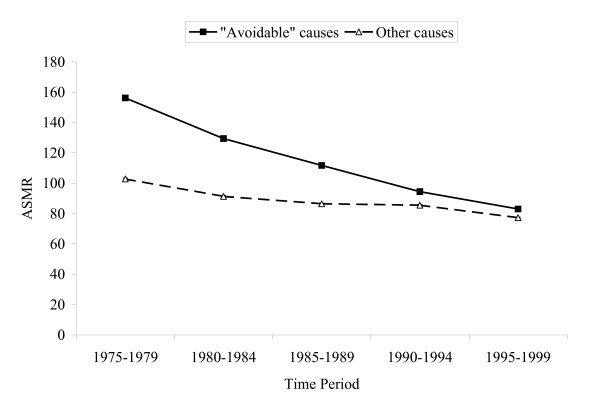
Mortality from 'avoidable' and other causes in Canada from 1975 to 1999. Abbreviation: ASMR = age-standardized mortality rate (per 100,000 population).